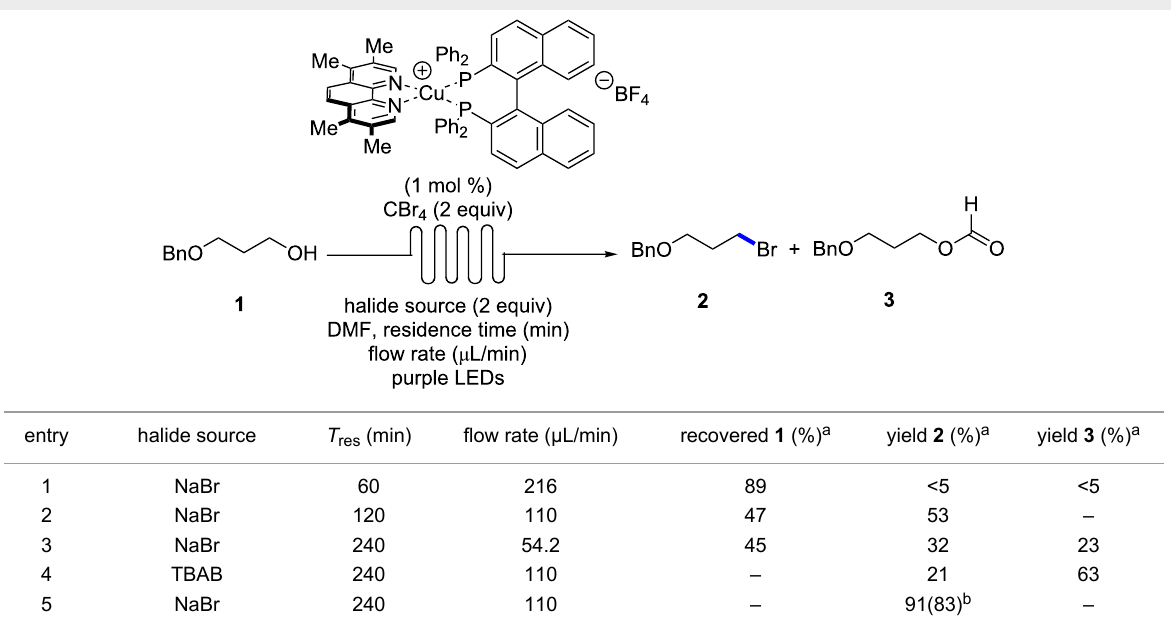
Table 2: Photocatalytic conversion of alcohol 1 to bromide 2 in continuous flow.